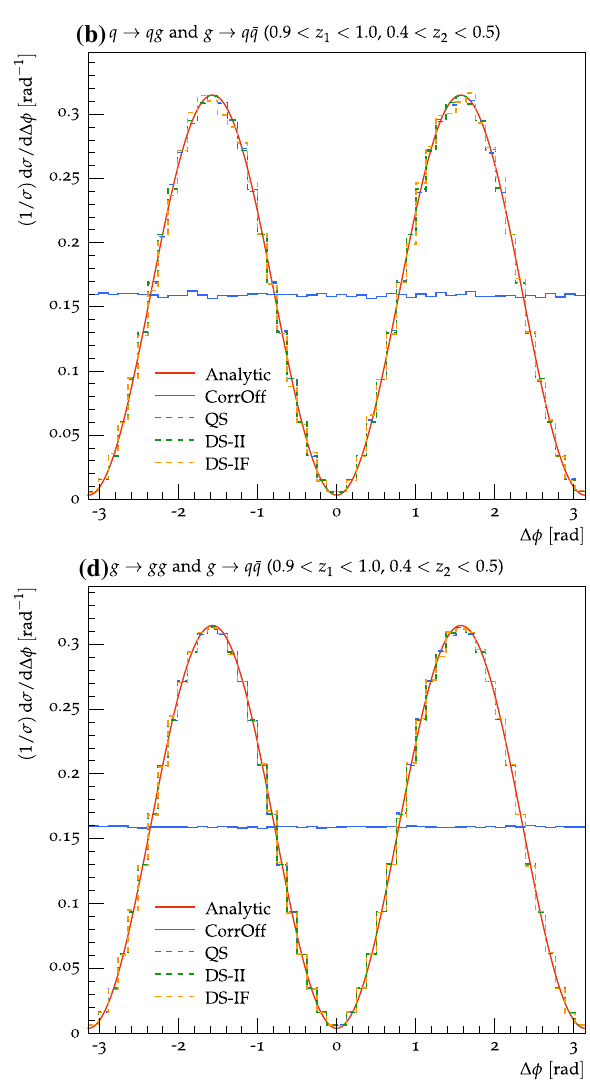
Fig. 2 Theanalyticresultforthedifferenceinazimuthalanglebetween the branching planes of subsequent initial-state a q → qg and g → gg , b q → qg and g → q ¯ q , c g → gg and g → gg and d g → gg and g → q ¯ q splittings compared to the distributions predicted using the angular-ordered (QS) and dipole parton showers in Herwig 7. The pre-